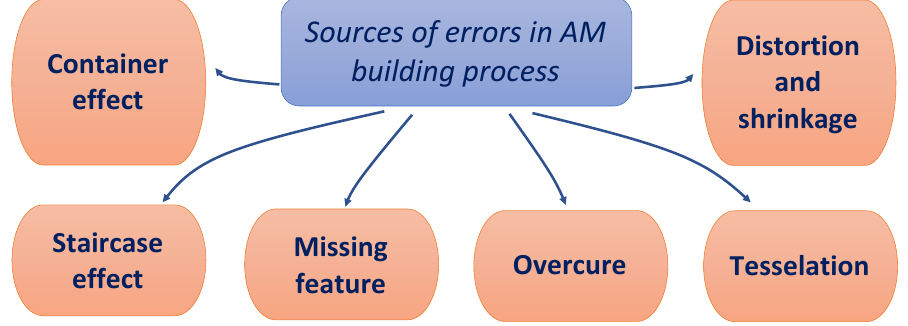
Figure 3. Sources of errors in Additive Manufacturing (AM) building process described in